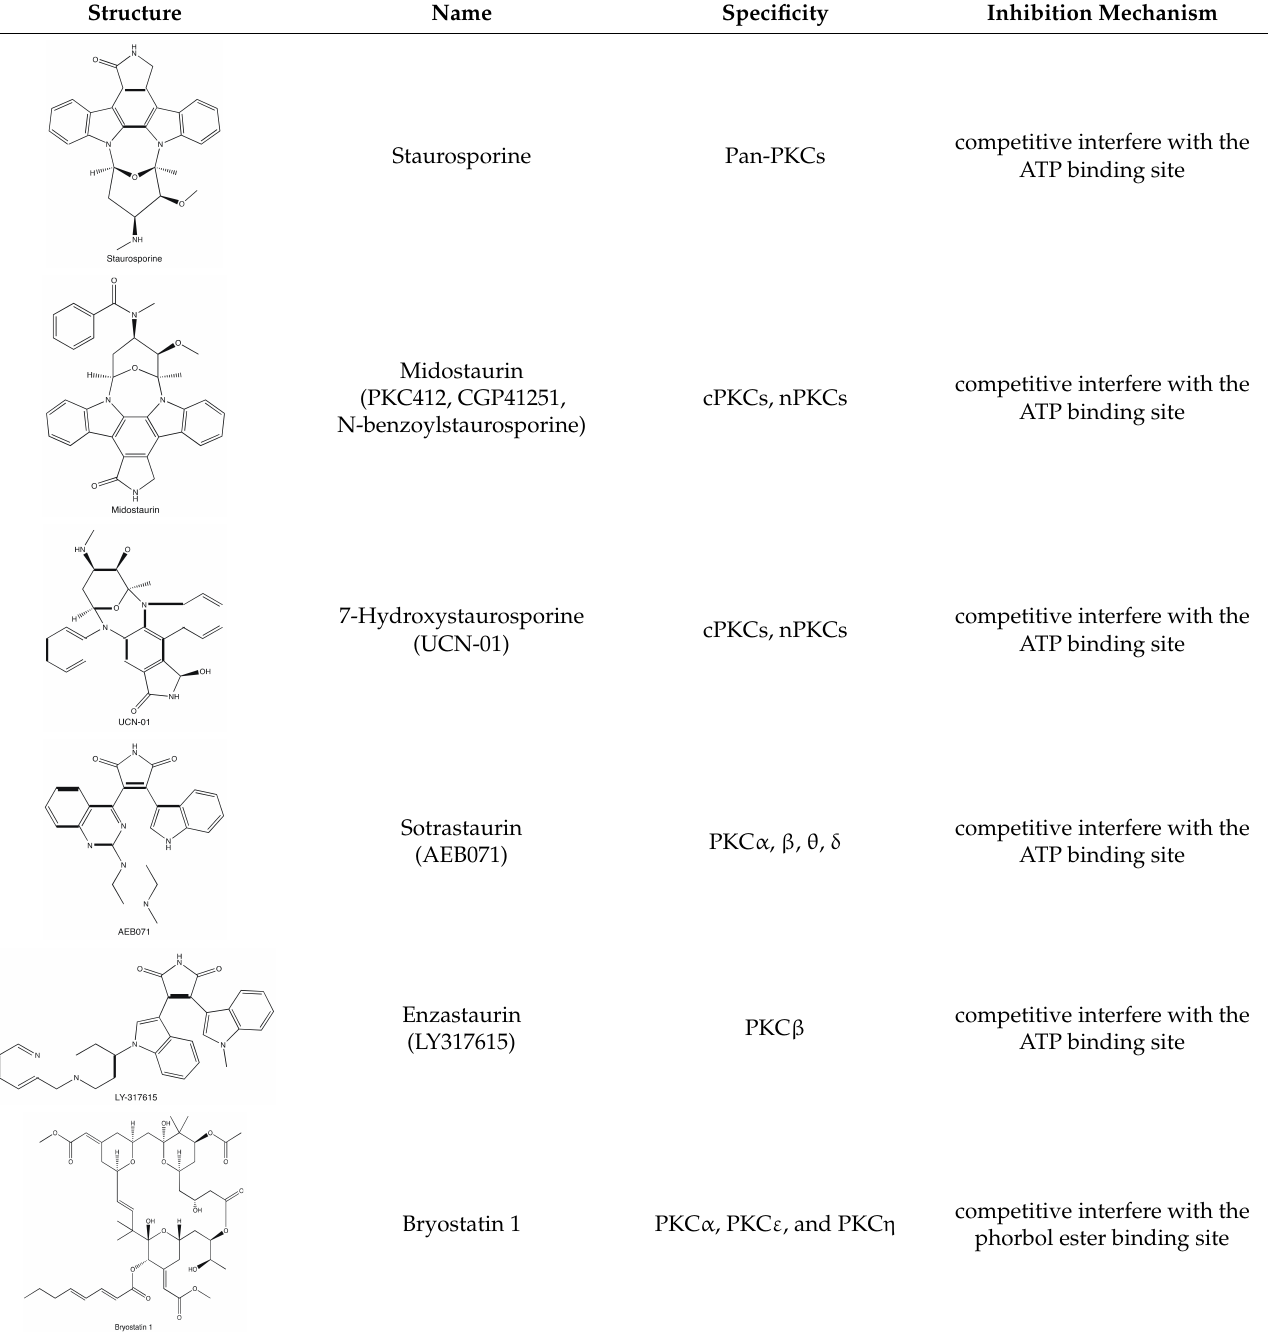
Table 1. Inhibitors of PKC